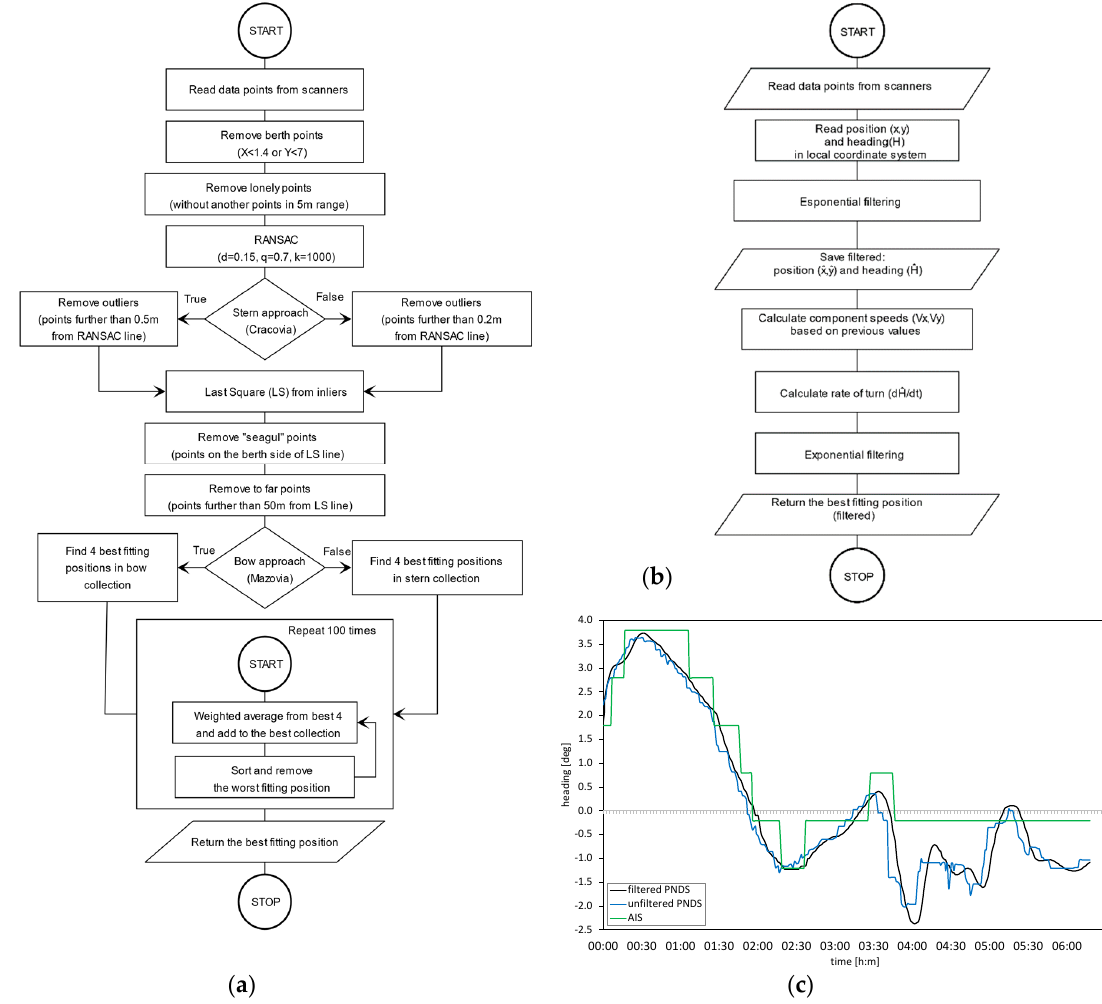
Figure 9. Algorithm for ship’s position estimation ( a ); estimation and smoothing algorithm for course and velocities ( b ) with processed ship’s true heading ( c